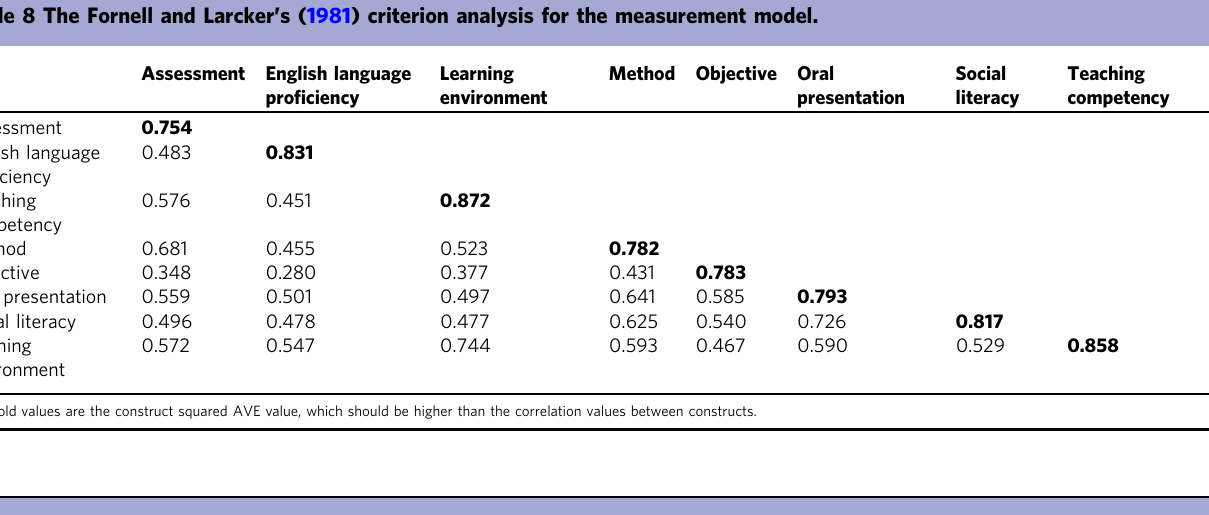
Table 9 The HTMT analysis for the measurement model.